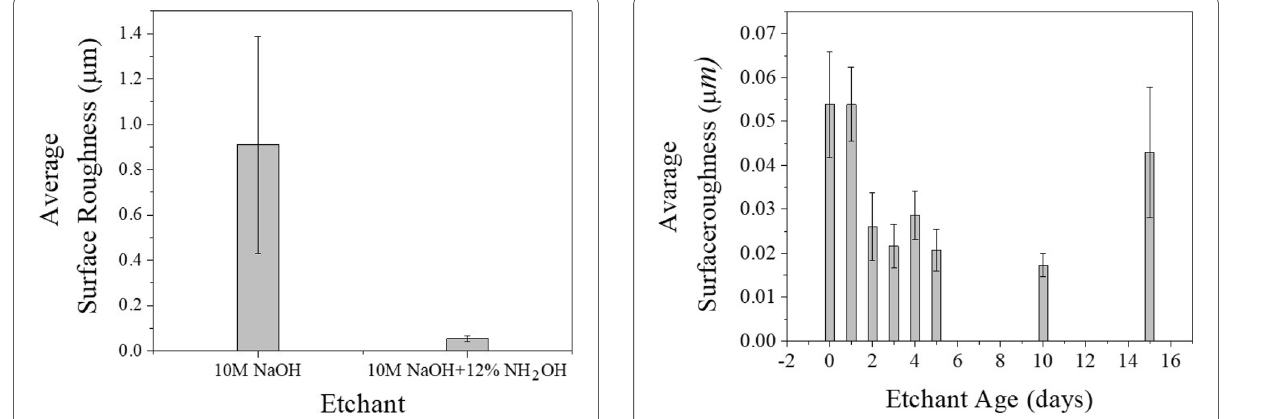
12% NH 2 OH) age on the +